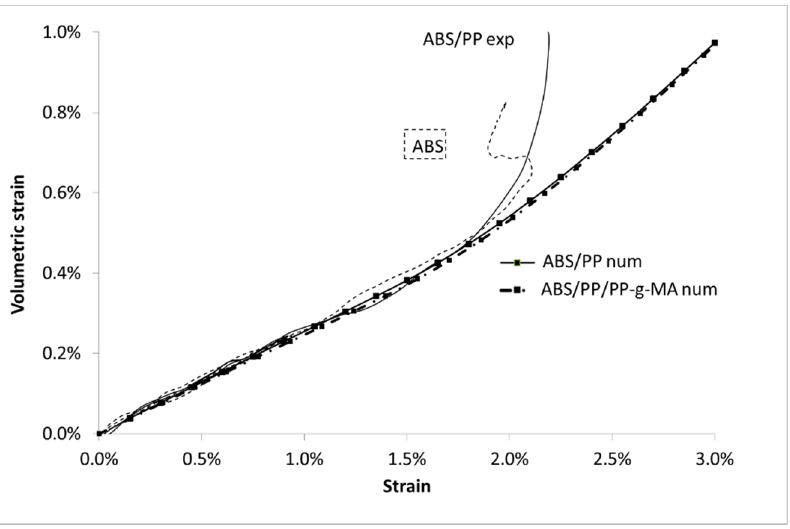
Figure 22. Volumetric strain vs. Lagrangian strain for ABS/PP composite, experiments, and model- ling.